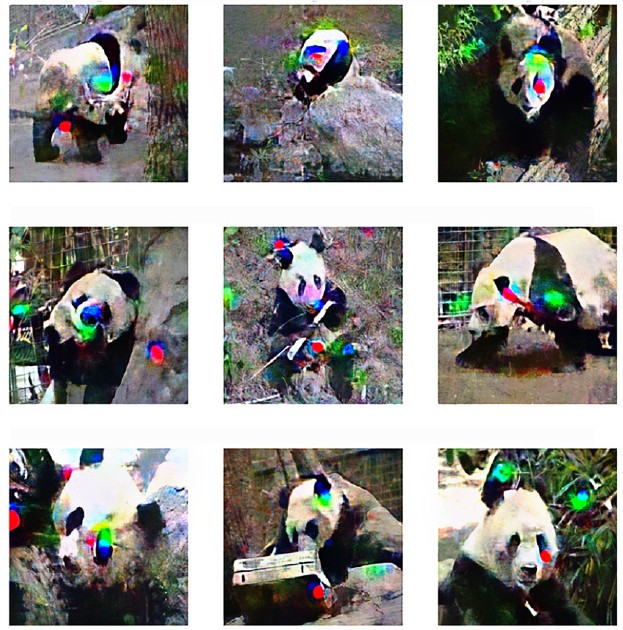
Figure 4. Results of denoised smoothing.